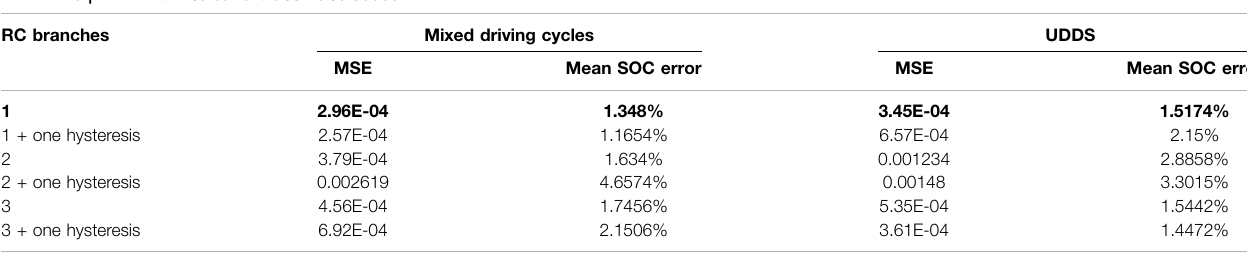
TABLE 10 | AEKF with 1% current bias noise